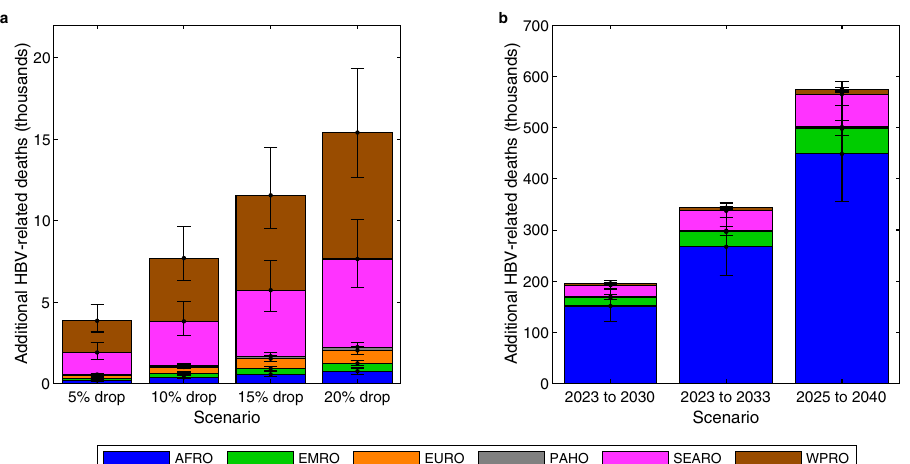
Fig. 5 The impact of disruptions to the scale-up of timely HepB-BD on HBV-related deaths. a Mean additional HBV-related deaths in the birth cohorts in 2020-2030 due to a drop in the proportion of new-borns receiving timely HepB-BD in 2020 (the HepB-BD disruptions scenarios) relative to the status quo HepB3 & HepB-BD scenario, with 95% credibility intervals. b Mean additional HBV-related deaths in the birth cohorts in 2020-2030 due to delays in scaling up timely HepB-BD coverage to ≥ 90% (the delayed HepB-BD scale-up scenarios) relative to scaling up timely HepB-BD coverage to ≥ 90% between 2020 and 2030 (the HepB-BD scale-up scenario), with 95% credibility intervals. Results are the sums within WHO regions from all modelled countries of n = 200 model outcomes resulting from 200 independent draws from the posterior distribution of each country. The six WHO regions AFRO, EMRO, EURO, PAHO, SEARO, and WPRO are shown in Supplementary Fig. 1. HBV: hepatitis B virus; HepB3: infant HBV vaccine series; timely HepB-BD: timely birth dose; WHO: World Health